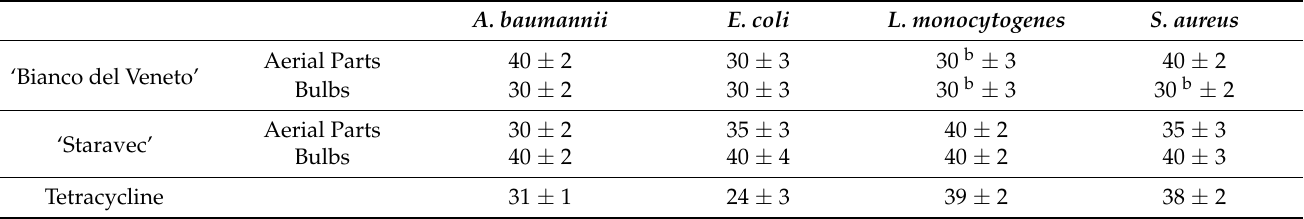
Table 2. Minimal inhibitory concentration ( µ L/mL) of the EOs from the A. sativum cultivars neces- sary to inhibit the growth of the pathogenic bacterial strains Listeria monocytogenes, Escherichia coli, Acinetobacter baumannii, Staphylococcus aureus